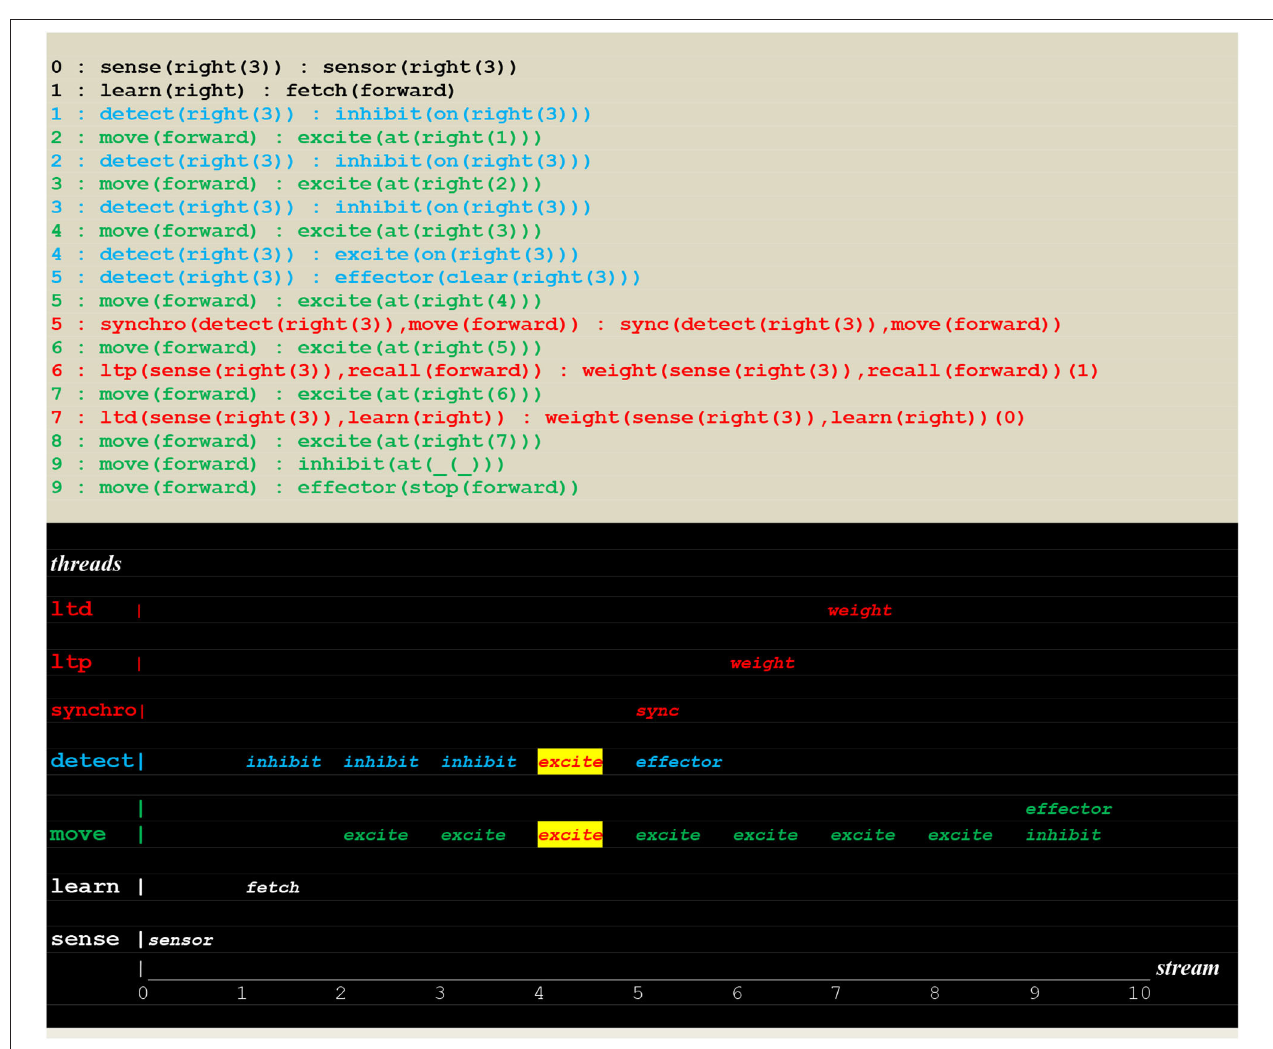
FIGURE 14 | Execution trace of learning a single move. Facing an open path to learn , a random choice learn(right):fetch(forward) successfully led to find the fire at position right(3) , activating a synchro thread that initiated ltp/ltd threads (see Figure 5 for the communication protocol of ltp/ltd ), thus inducing synaptic weight changes into instantiated links and leading in turn to both open the path to (sense(right(3)),recall(forward)) and close the path to ( sense(right(3)),learn(right))